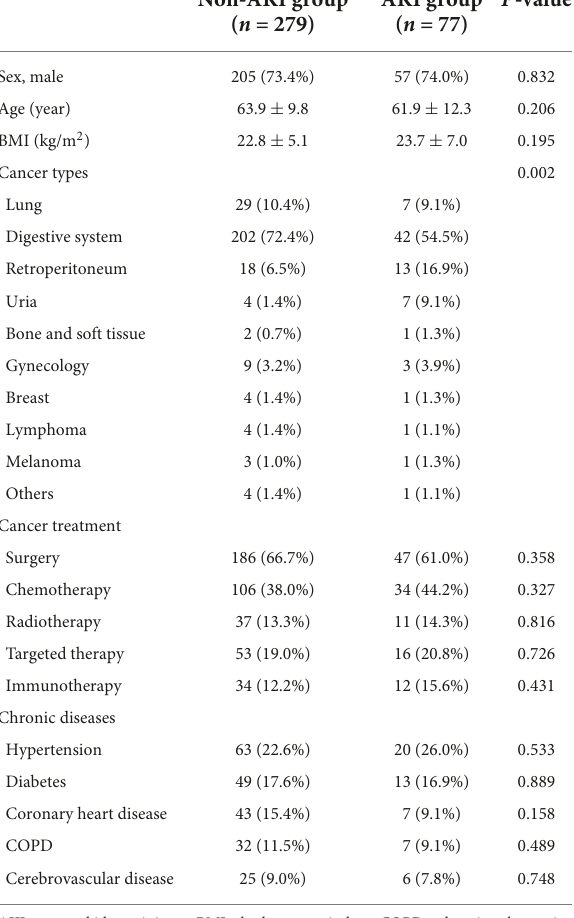
TABLE 1 Demographic data and characteristics of the two groups.